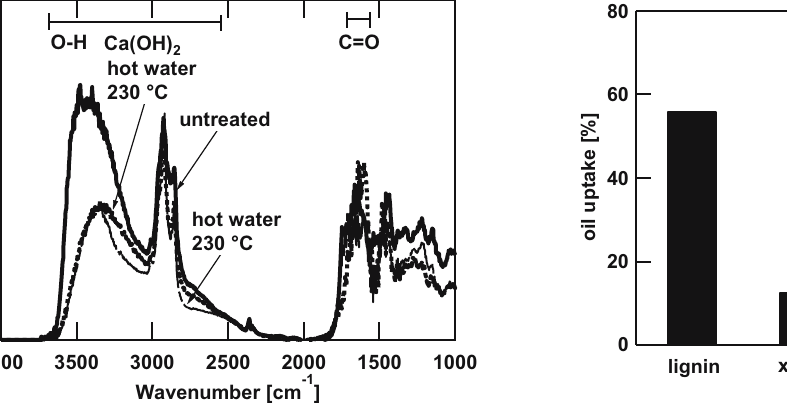
Figure 4: FTIR spectra of the co ff ee grounds treated in hot water and of the untreated ones.